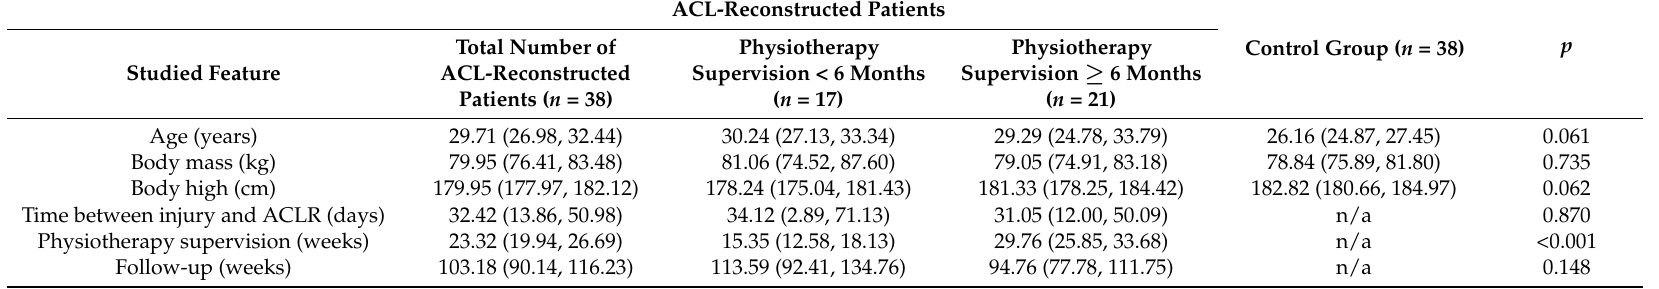
Table 1. Characteristics of studied participants; ACL: anterior cruciate ligament; ACLR: anterior cruciate ligament reconstruction; n : number of individuals; n/a: not applicable; p : level of statistical significance of the difference between patients with postoperative physiotherapy supervision < 6 months and patients with postoperative physiotherapy supervision ≥ 6 months, and control group; vGRF BM: vertical ground reaction force normalized to body mass. Values are expressed as the arithmetic mean and 95% confidence